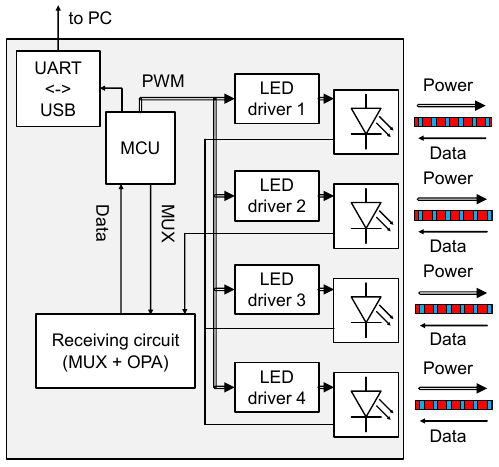
Figure 18. Block diagram of the sensor central